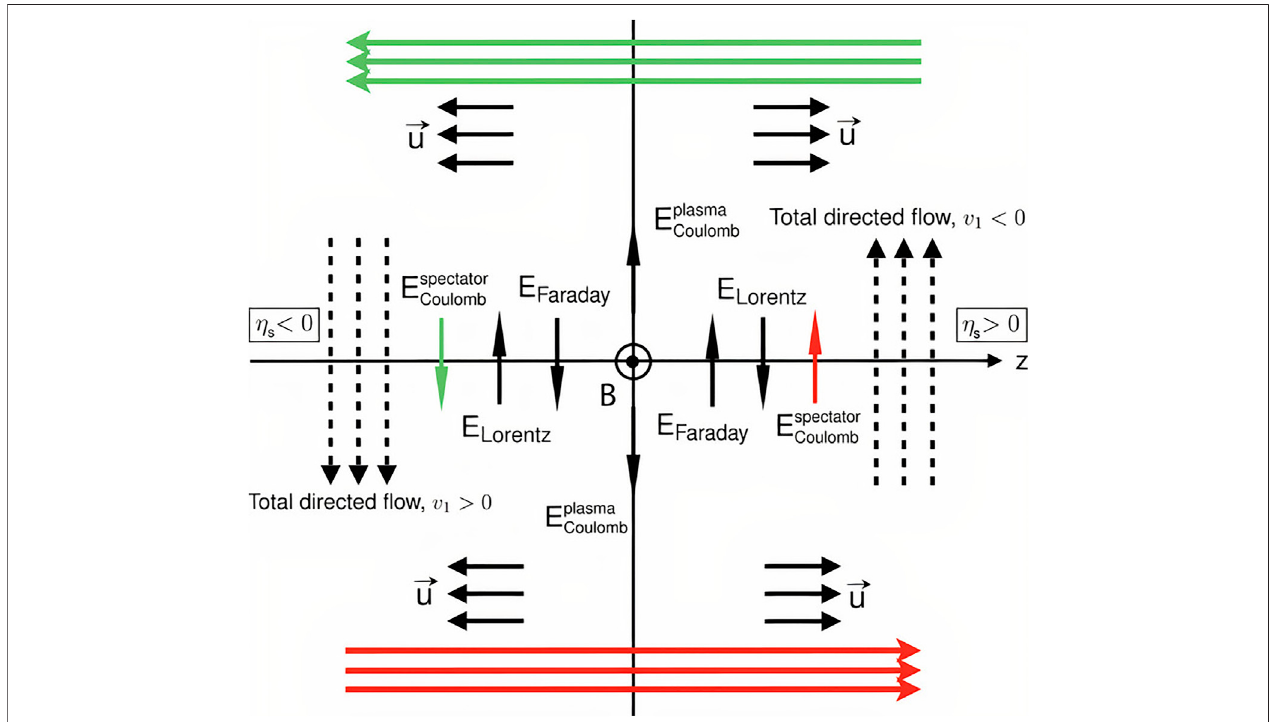
FIGURE 1 | (Color online) Schematic illustration of how the electromagnetic fi elds in a heavy-ion collision result in a directed fl ow of electric charge [12].